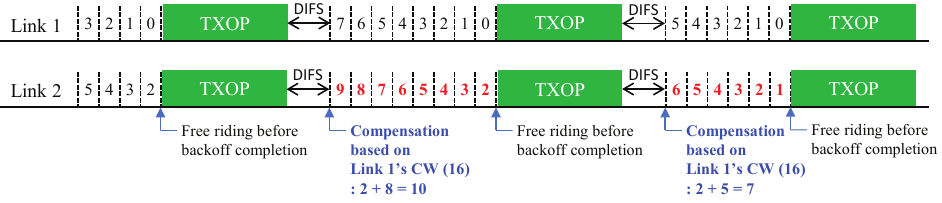
Figure 5. Proposal 3: using the CW value of a main link (backoff count values after compensation are colored red).